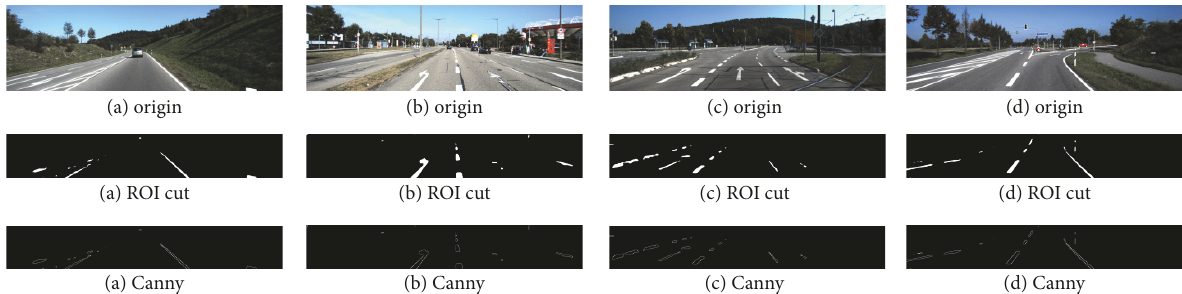
Figure 11: Canny edge detection of sample frames (a), (b), (c), and (d) after the proposed preprocessing.